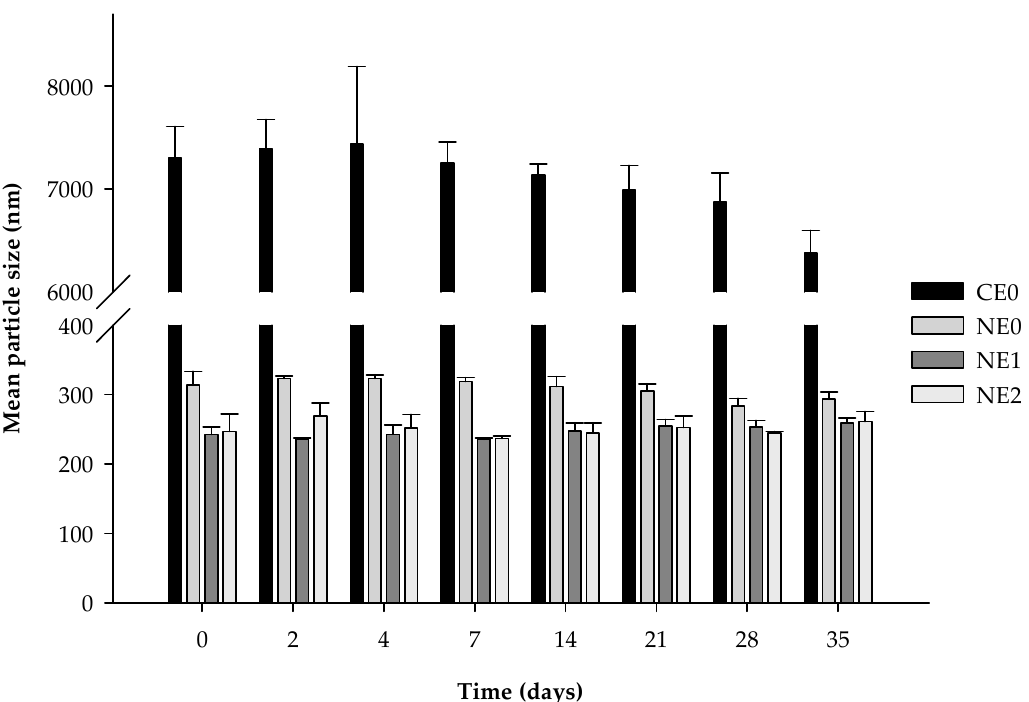
Figure 3. Mean particle size ( d 32 ) of coarse emulsion and nanoemulsions with different pectin concentrations (0%, 1%, and 2%) during 35 days of storage at 4 °C. CE0, coarse emulsion without pectin; NE0 nanoemulsion without pectin; NE1, nanoemulsion with 1% of pectin; NE2, nanoemulsion with 2% of pectin.